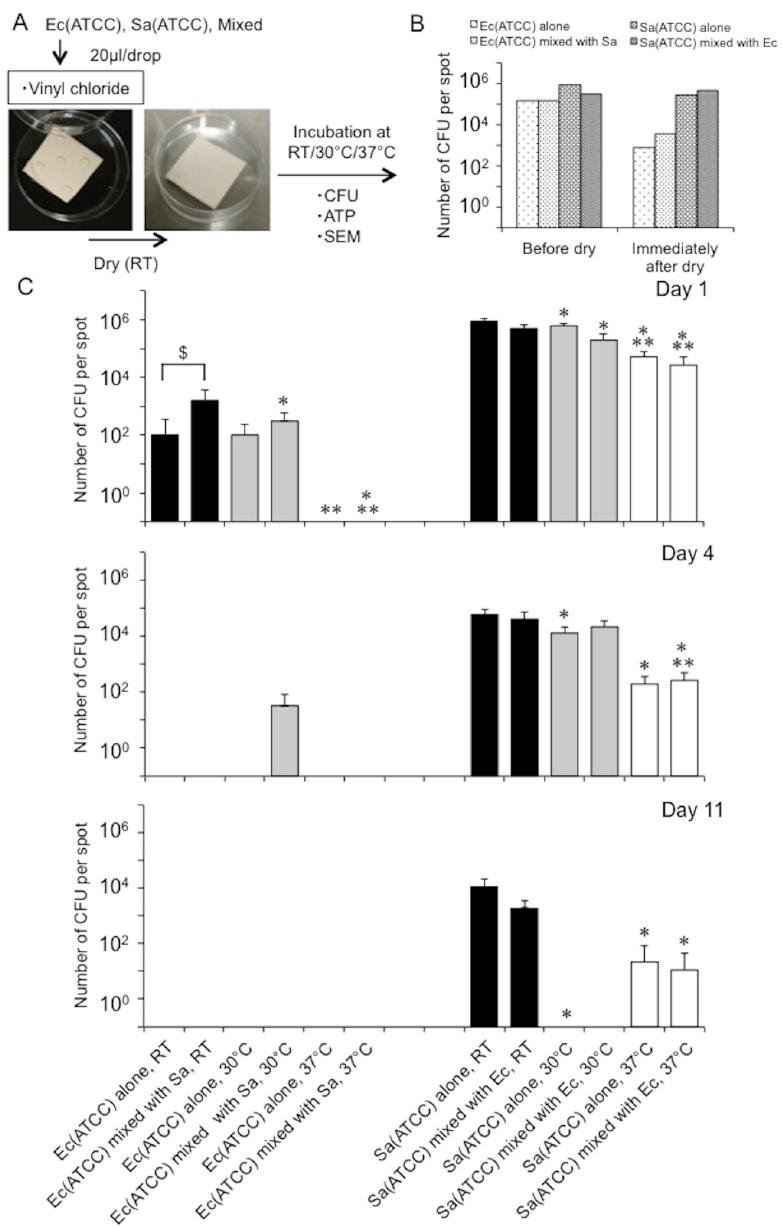
Fig 1. Representative human pathogenic bacteria favor lower temperatures for their survival on vinyl chloride surfaces. A . Experimental protocol. Bacterial survival was monitored for mixed or single bacteria on vinyl chloride at distinct temperatures [RT (around 20˚C), 30˚C, 37˚C] for 11 days by a CFU assay (CFU), ATP assessment (ATP) and morphological changes (SEM). Ec, E . coli (ATCC 25922). Sa, S . aureus (ATCC 29213). B . Bacterial numbers immediately (within 20 min) after drying. Ec, E . coli (ATCC 25922). Sa, S . aureus (ATCC 29213). C . Changes in bacterial numbers at distinct temperatures [RT (around 20˚C), 30˚C, 37˚C] over 11 days, as determined by a CFU assay. Ec, E . coli (ATCC 25922). Sa, S . aureus (ATCC 29213). � , p < 0.05 vs. the values at room temperature. �� , p < 0.05 vs. 30˚C. †, p < 0.05 between the bars.